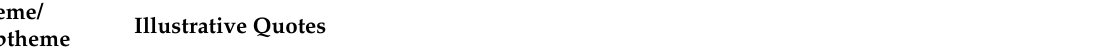
Table A2. Quotes to illustrate categories of